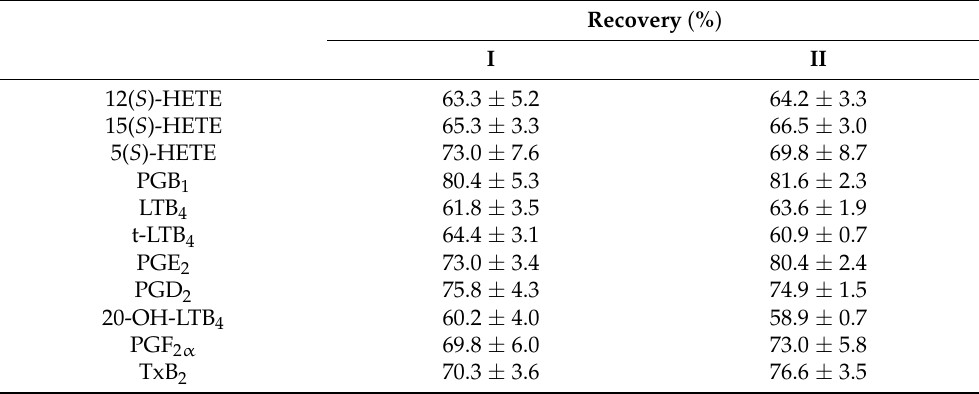
Table 3. The recovery rate is expressed as a percentage amount of analyte at two concentration levels (I = 50 ng, II = 125 ng) found in spiked neutrophil samples of three donors. Results are shown as mean ±